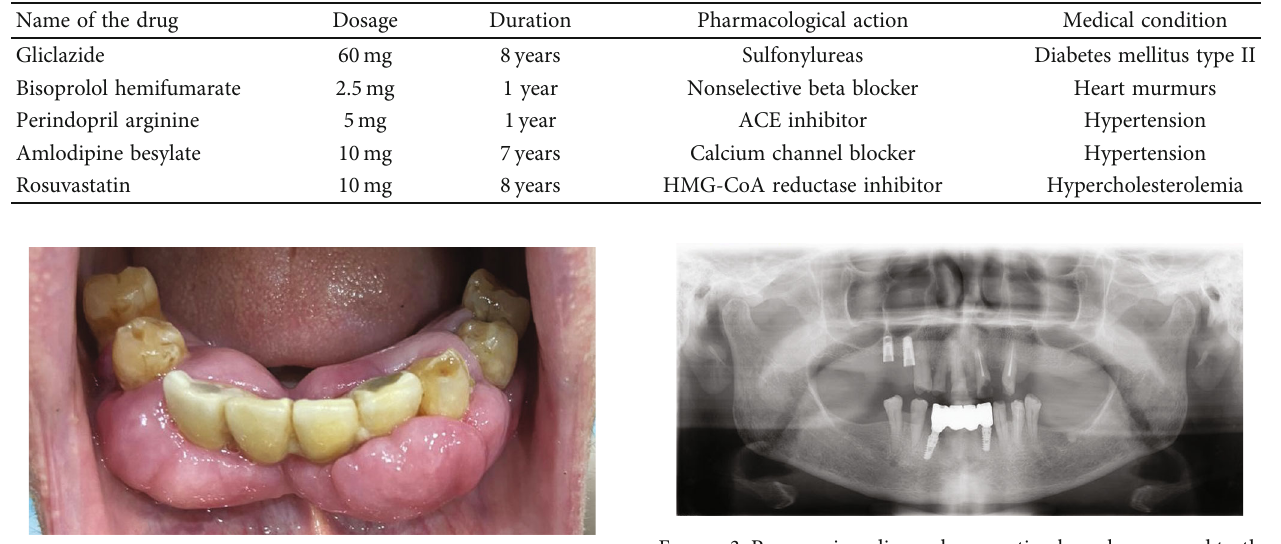
Figure 1: Fibrous, nodular, hard gingival overgrowths extending to most of the clinical crown in the anterior and posterior parts of the mandibular arch.